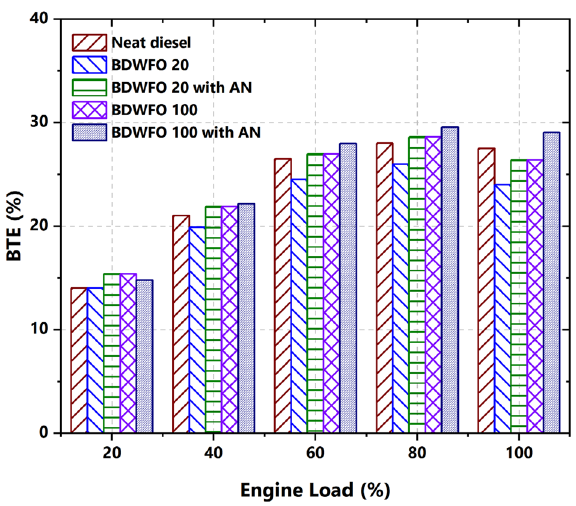
Figure 3. BTE—brake thermal efficiency (%) with respect to Load variation